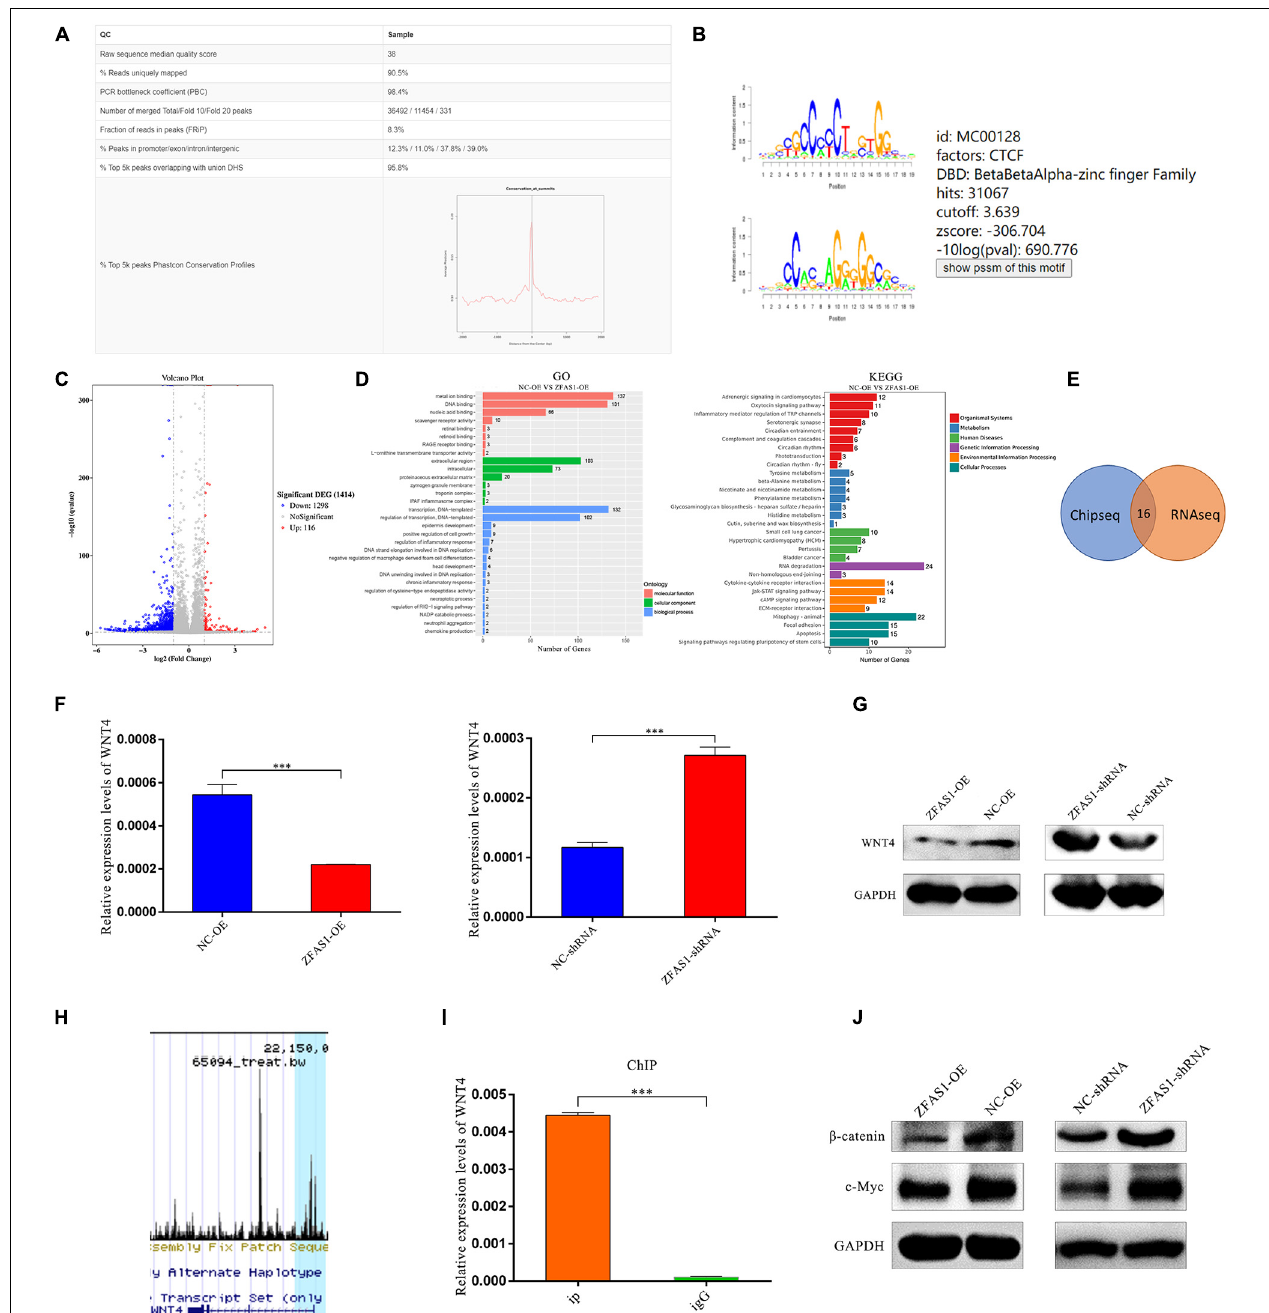
FIGURE 6 | ZFAS1 inhibited WNT/ β -catenin signaling pathway via suppressing WNT4 expression levels by binding with CCCTC-binding factor (CTCF). (A) The quality report of chromatin immunoprecipitation sequencing (ChIP seq) of CTCF mined in the Cistrome Data Browser. (B) The annotated binding motif of CTCF from the mined ChIP seq. (C) The volcano plot of differentially expressed genes from the RNA seq of human oral keratinocyte (HOK) cells overexpressing ZFAS1. The fold change threshold is 1.5, and P -value ≤ 0.05. The red dots indicate upregulated genes, the blue dots indicate downregulated genes, and the gray dots indicate non-differentially expressed genes. (D) The gene ontology (GO) and Kyoto Encyclopedia of Genes and Genomes (KEGG) pathways enriched in differentially expressed genes. Length of the bar represents the amount of differentially expressed genes enriched in the pathway. (E) The integrated analysis of ChIP seq and RNA seq. The intersection region indicates the merged genes of them. (F) ZFAS1 negatively regulated expression levels of WNT4 by qPCR assay. (G) ZFAS1 negatively regulated protein levels of WNT4 by western blotting (WB) assay. (H) The peak of WNT4 from the ChIP seq of CTCF. The blue highlight indicates the peak. (I) The binding capacity of CTCF to WNT4 was measured by ChIP qPCR assay. (J) ZFAS1 negatively regulated protein levels of β -catenin and c-Myc by WB assay. Values are mean ± SEM, n = 3, *** P < 0.0001.